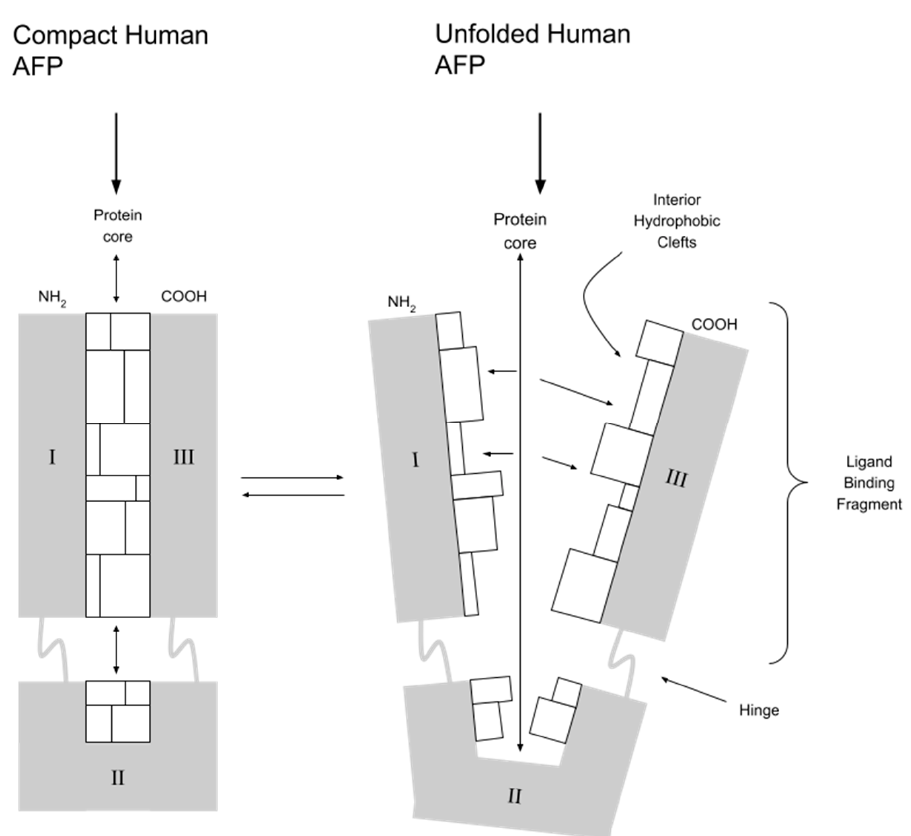
Figure 2. AFP and its hydrophobic pocket between domain I and III . I, II, III – peptide domains of human AFP